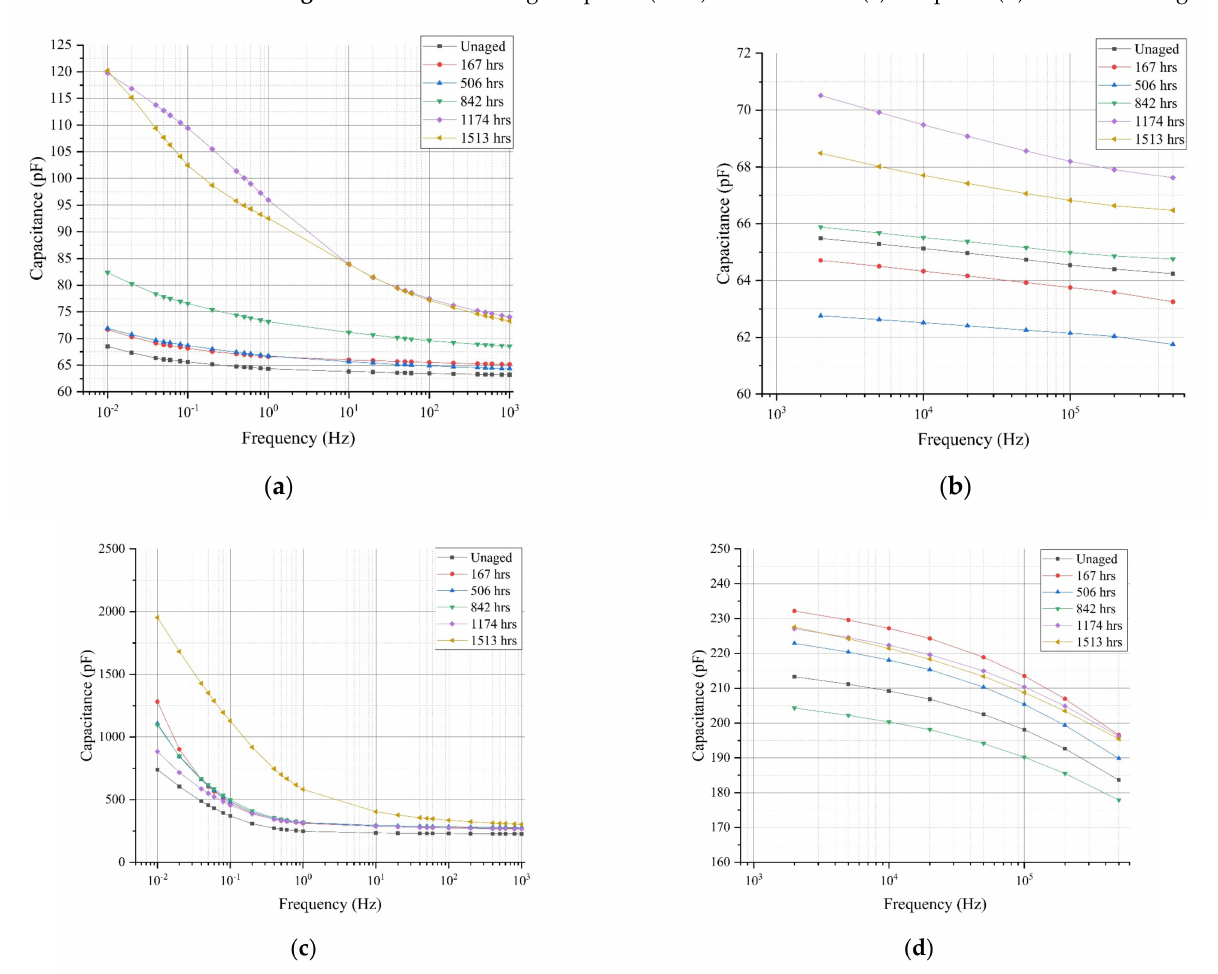
Figure 4. Capacitance vs. frequency, EPR insulation: ( a ) 10 mHz to 1 kHz, ( b ) 2 kHz to 500 kHz, CSPE jacket, ( c ) 10 mHz to 1 kHz, and ( d ) 2 kHz to 500 kHz for different thermal aging